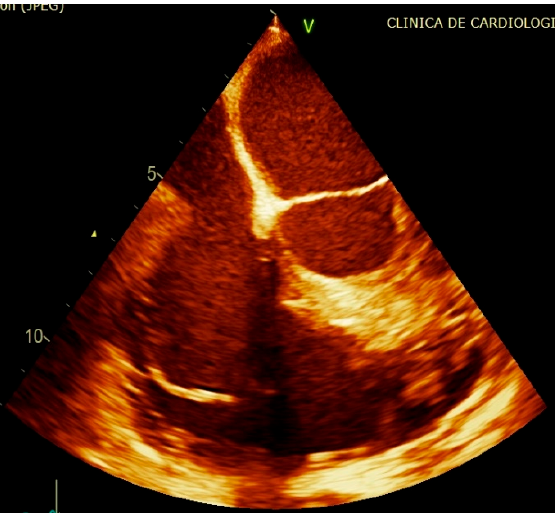
Figure 7. Transesophageal two-dimensional echocardiography: tricuspid chordae rupture, no residual vegetation, no pericardial effusion.